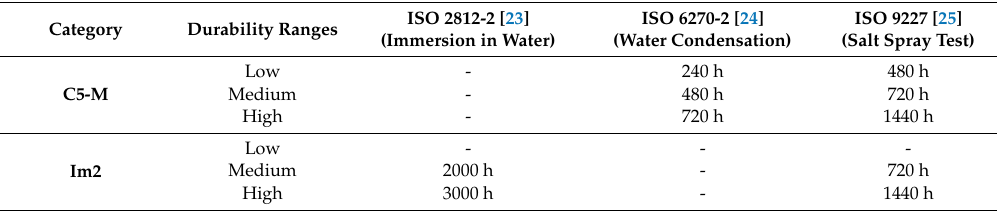
Table 3. Minimum exposure time for the coatings to achieve the C5-M and Im2 categories according to the ISO 12944 standard